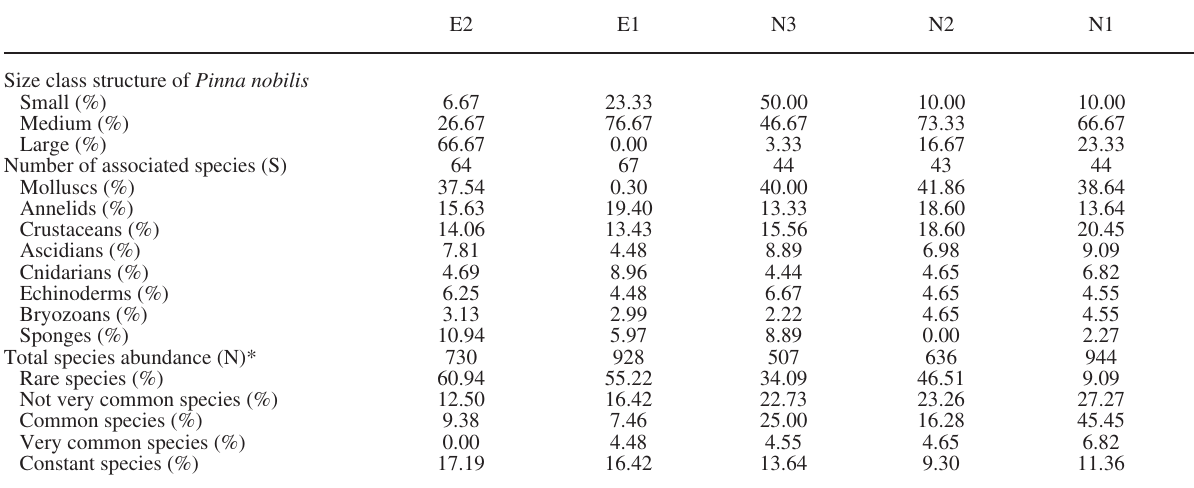
Table 2. – Percentages of Pinna size and species categories, phyla, species richness and total species numbers recorded at the five study sites. n1 echaara, n2 njila, n3 Sidi Rais, e1 Stah Jaber, e2 teboulba. e2